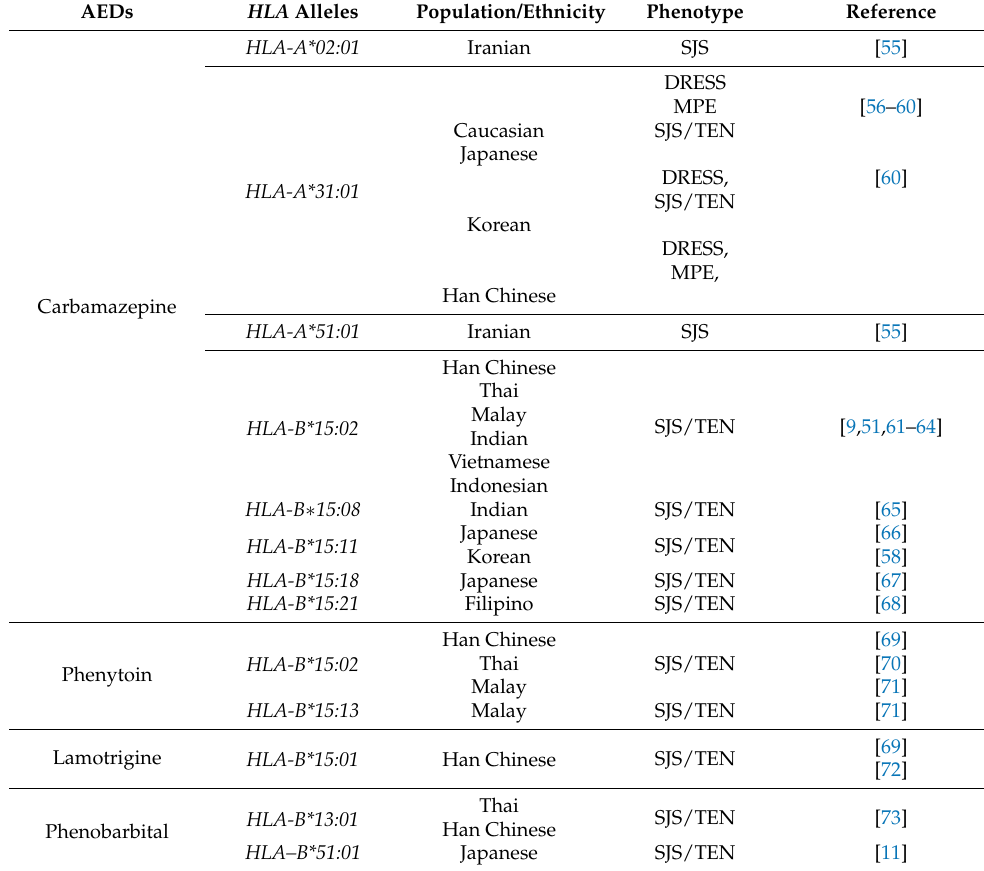
Table 1. Ethnicity and phenotype specific association between HLA allele and AED-induced SCARs. AEDs HLA